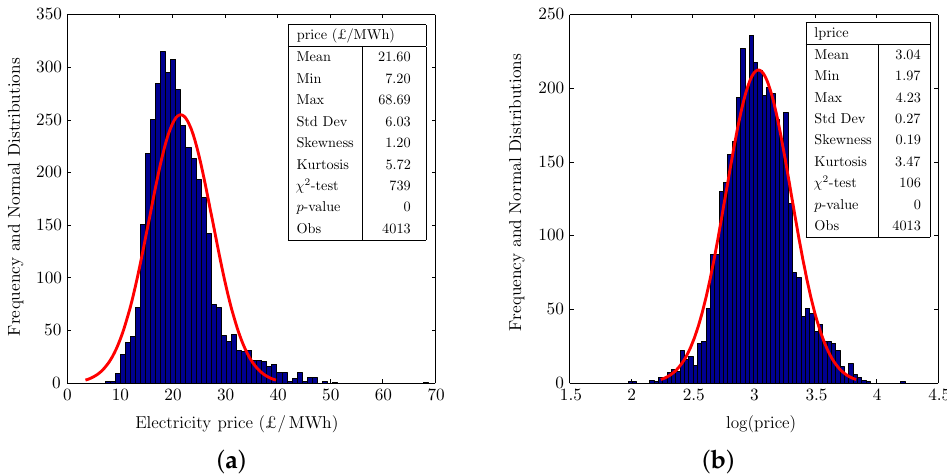
Figure 1. Distribution of demand weighted average price and log of demand weighted average price over trading days (1 April 1990–26 March 2001). Author’s